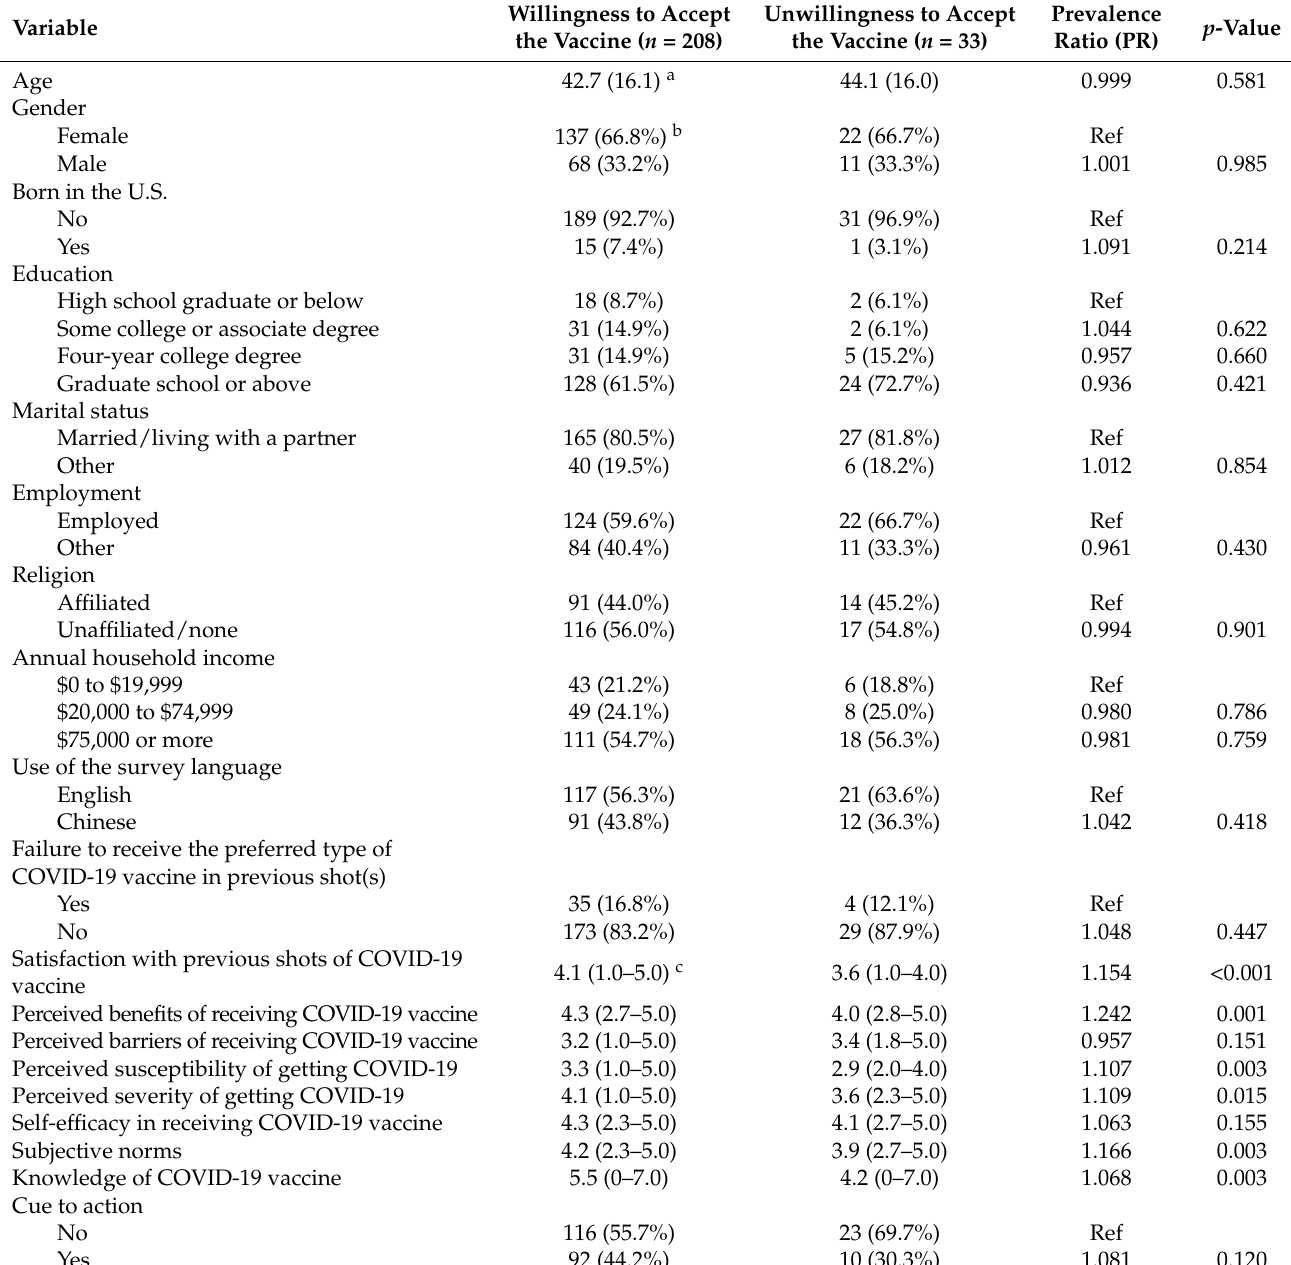
Table 1. Socio-demographic characteristics and survey responses of study participants who are willing to receive the annual dose of COVID-19 vaccine compared to those who are unwilling to receive the vaccine ( n =